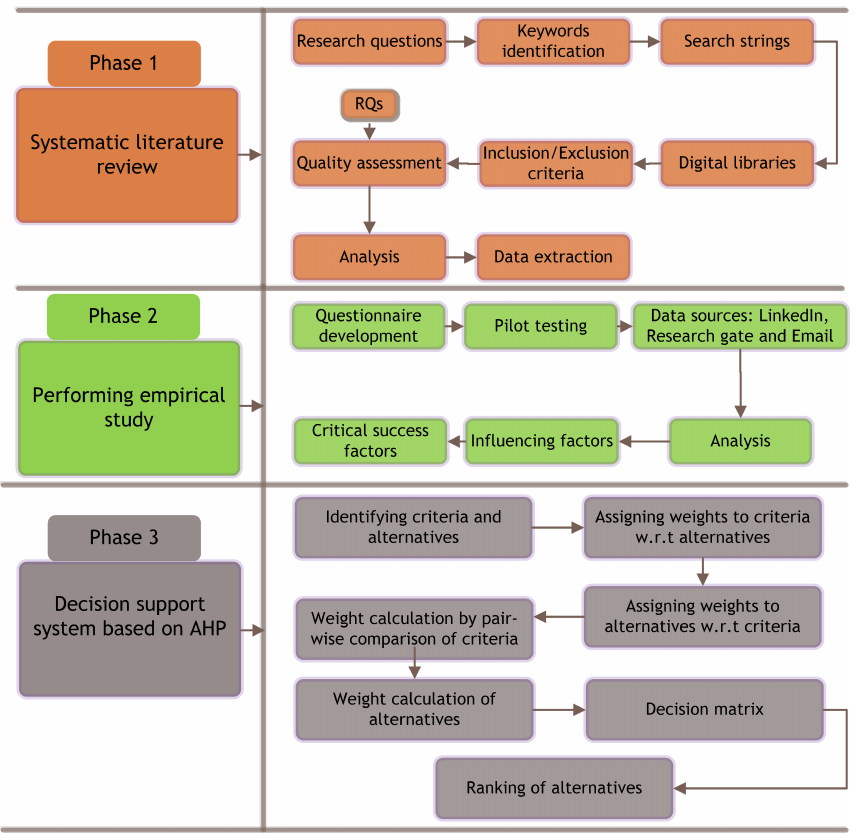
Figure 1. The proposed method of